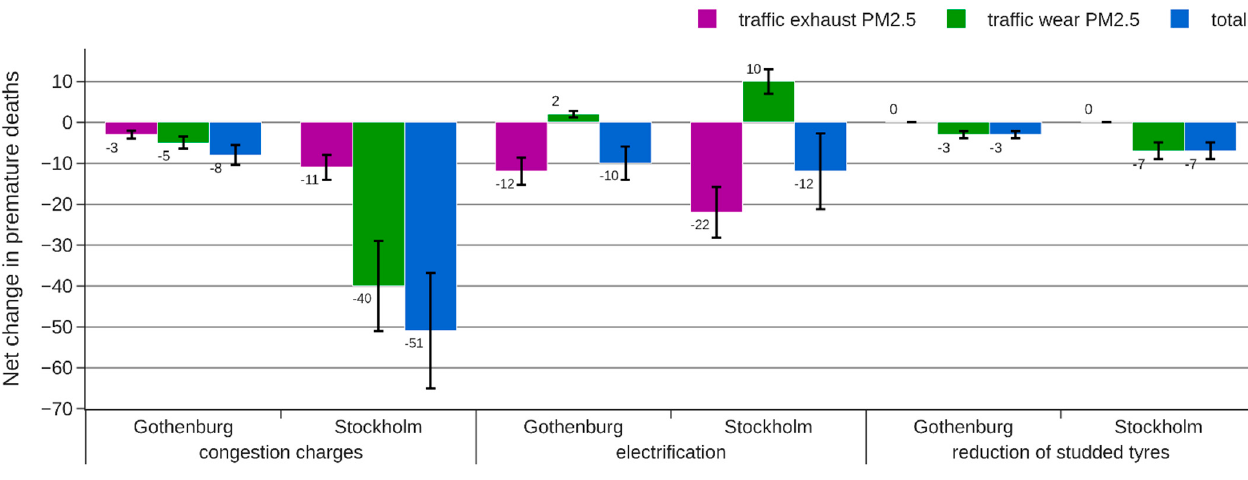
Figure 8. Estimated change in number of premature deaths for each of the abatement strategies following approach C (separation by source category and distance). The error bars represent a 95% CI.